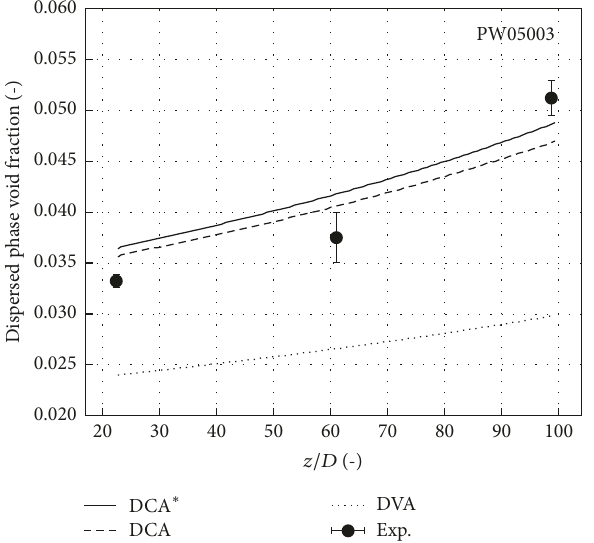
Figure 9: Comparison of mean bubble size axial evolution for the different drag approaches.